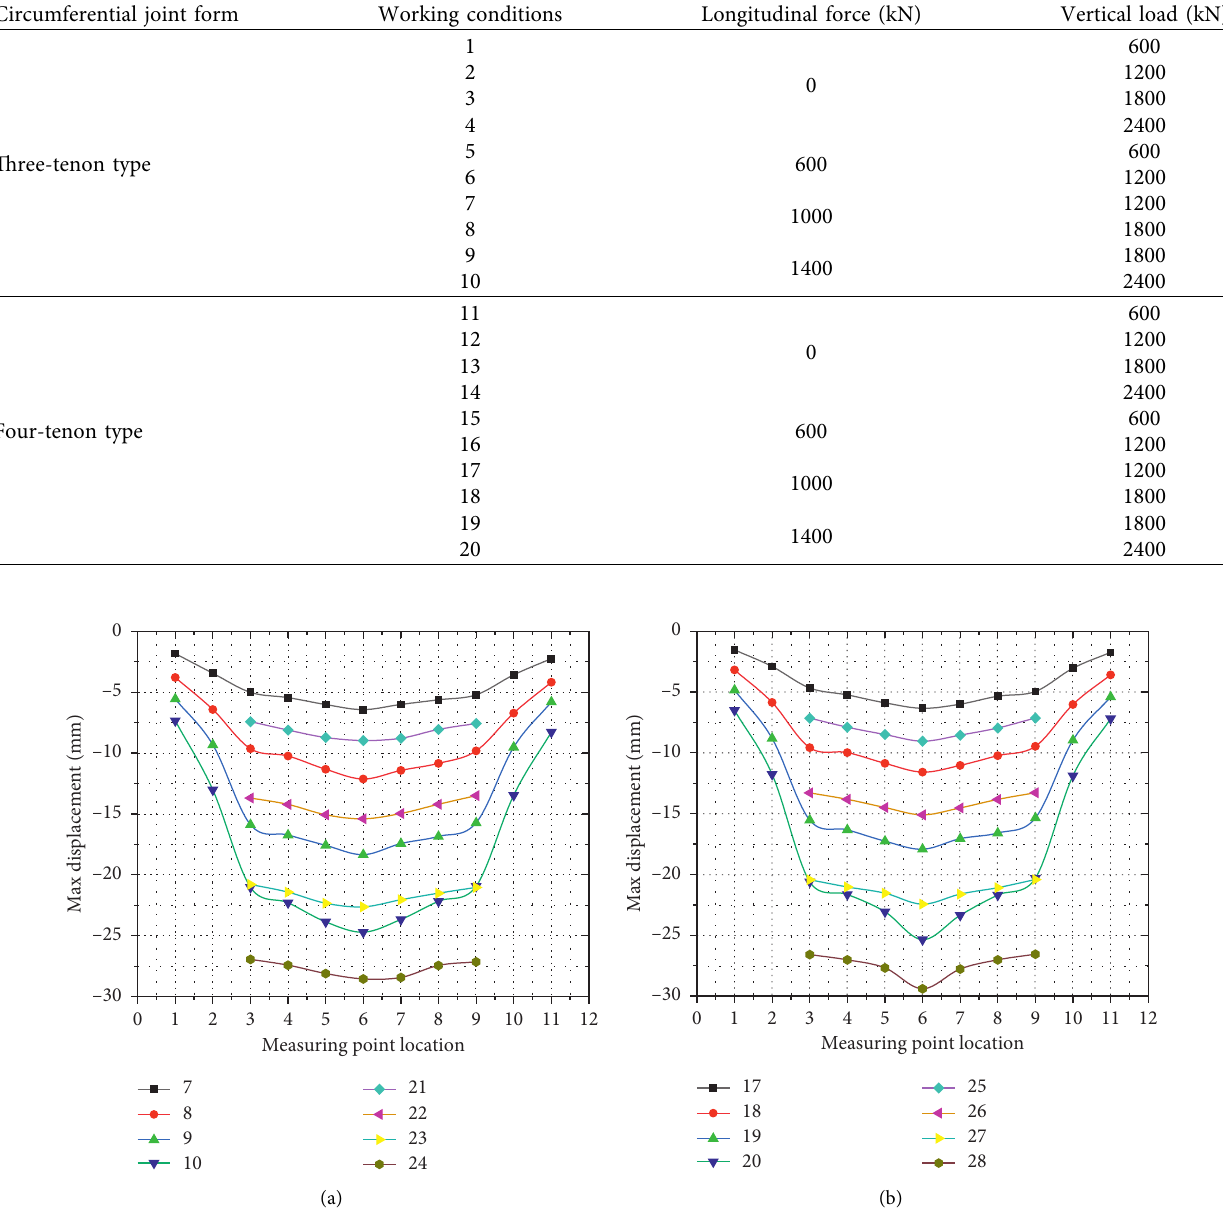
Figure 8: The maximum displacement of single segment and three segments along the width direction under vertical loads. (a) Maximum displacement of three-tenon type segment along width direction. (b) Maximum displacement of four-tenon type segment along width